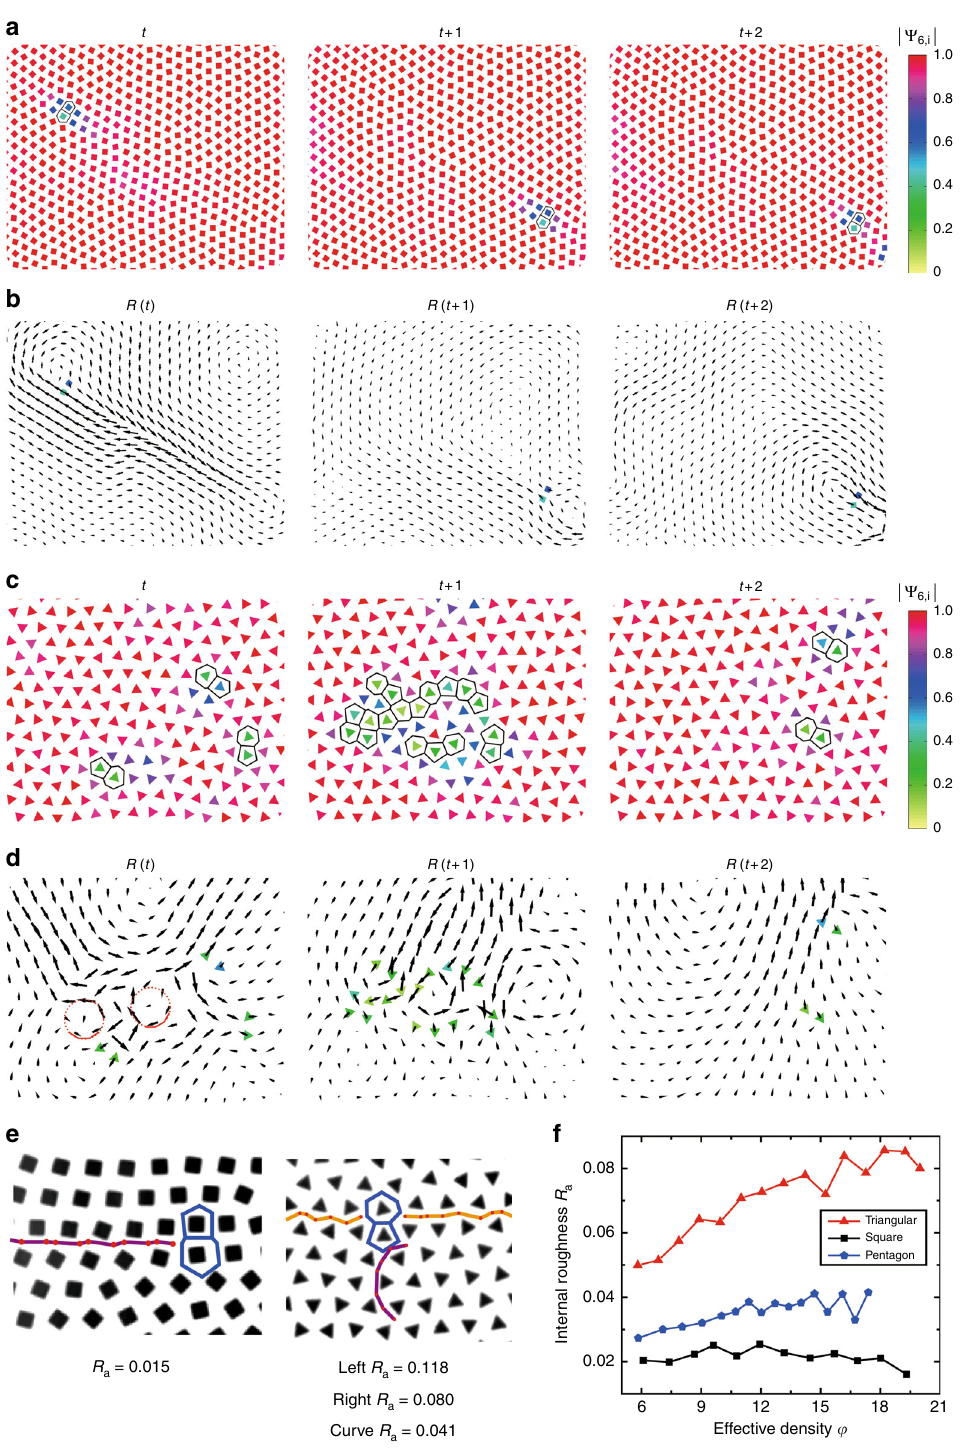
Fig. 3 Relaxation dynamics determined by vertex structures. a the square system relaxes through dislocation gliding. The 5 – 7 pair is labeled by two polygons and the particle color represents order parameter. b The displacement fi eld, R( t ), for the gliding event in a . R( t ) represents the displacement from frame t to t + 1 and large displacements concentrate along the gliding line. Colored particles indicate the 5 – 7 pair. c the triangle system relaxes via defect loops. d the displacement fi eld of the relaxation event in c . Colored particles indicate defects. The red circuits label motif 3 structures which highly correlate with the excitation fi eld and provide a structural basis for defect loop. e the internal roughness, R a , is small in square system but much larger in triangle system. However R a reduces signi fi cantly along a nearby motif 3 structure. The two polygons indicate the 5 – 7 pair dislocation. f average R a along all lattice lines in triangle, square, and pentagon